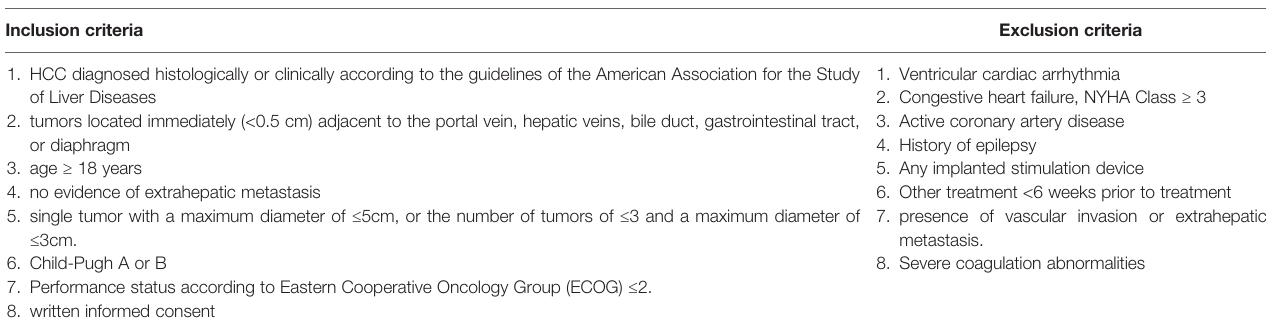
TABLE 2 | Patients inclusion and exclusion criteria.